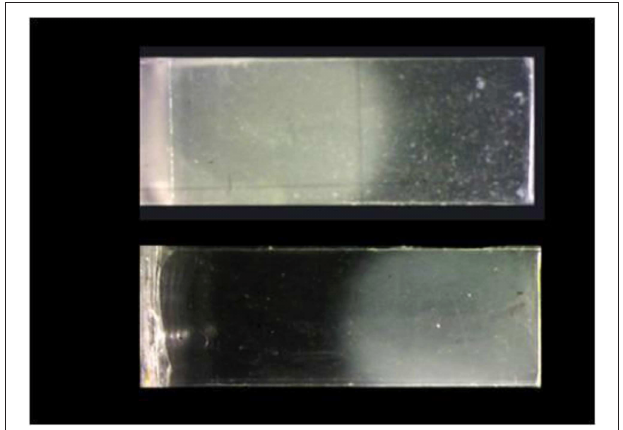
FIGURE 5 | Images of hydrolyzed samples of micro-injected biphasic PLA sample (amorphous gate, crystalline tip).